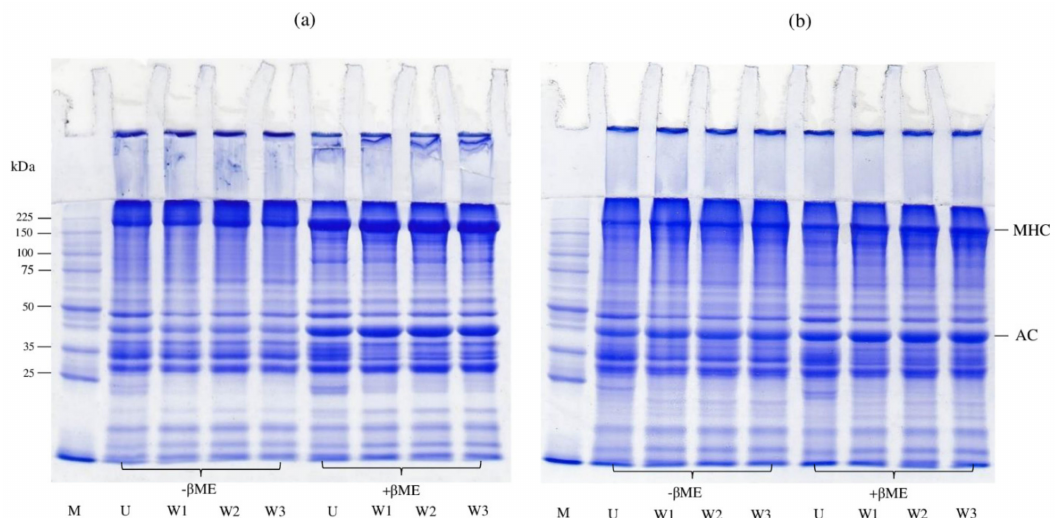
Figure 4. SDS-PAGE patterns before ( a ) and after gelation ( b ) of proteins from unwashed mince (U) and surimi from Indian mackerel prepared by one washing cycle (W1), two washing cycles (W2), and three washing cycles (W3). MHC, myosin heavy chain; AC, actin; M, protein markers; − β ME, without β -mercaptoethanol; + β ME, with β -mercaptoethanol. Samples (15 µ g protein) were loaded onto the polyacrylamide gels comprising a 10% running gel and a 4% stacking gel, and subjected to electrophoresis at a constant current of 15